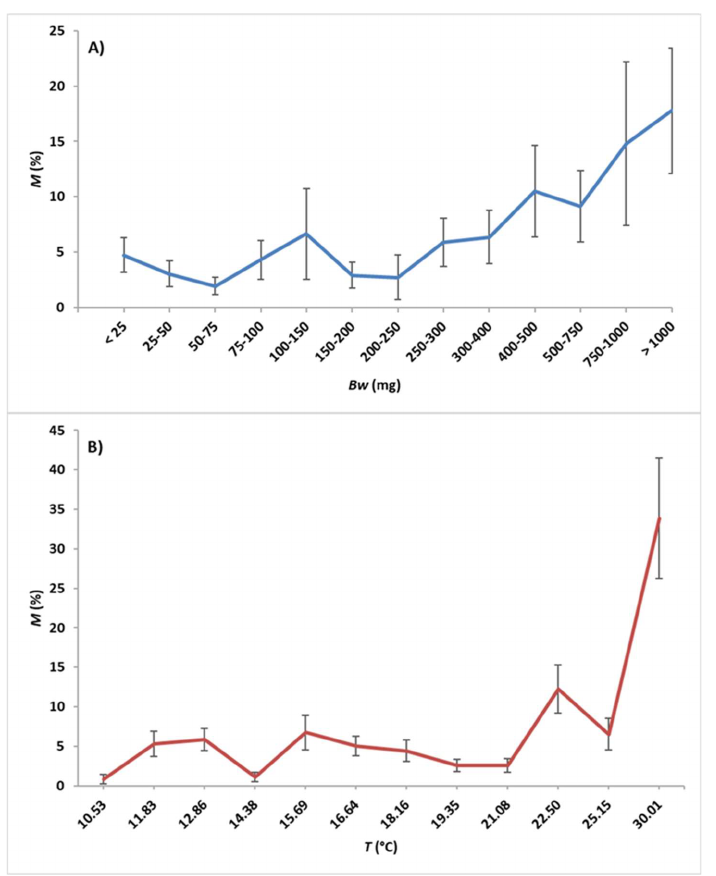
Figure 3. Mean mortality ( M ) observed in different ( A ) weight classes and ( B ) temperatures (bars = standard error).